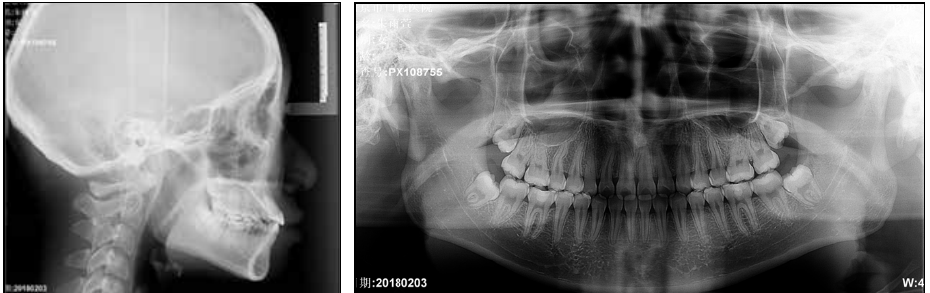
Figure 13. Radiographs at six years of